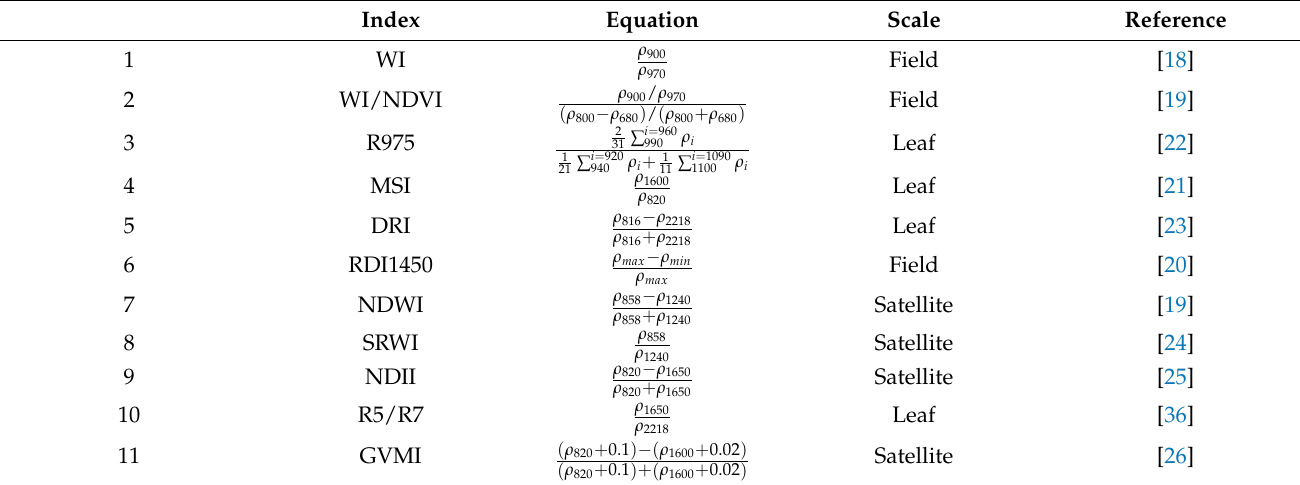
Table 3. Equations and references of the vegetation water